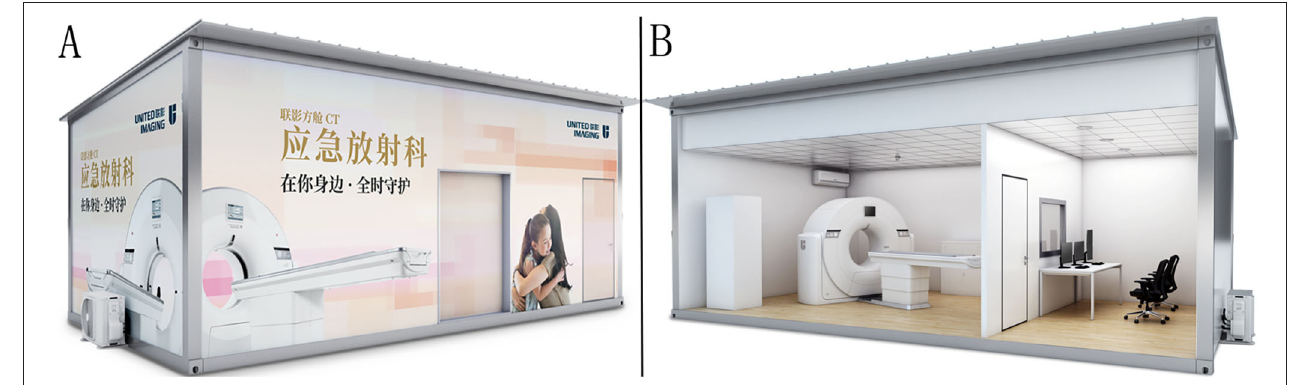
FIGURE 1 | The structure of the relocatable CT system. (A) The outward appearance of the relocatable CT system. (B) The interior structure of the relocatable CT system. The figures were provided through the courtesy of Shanghai United Imaging Healthcare Co.,